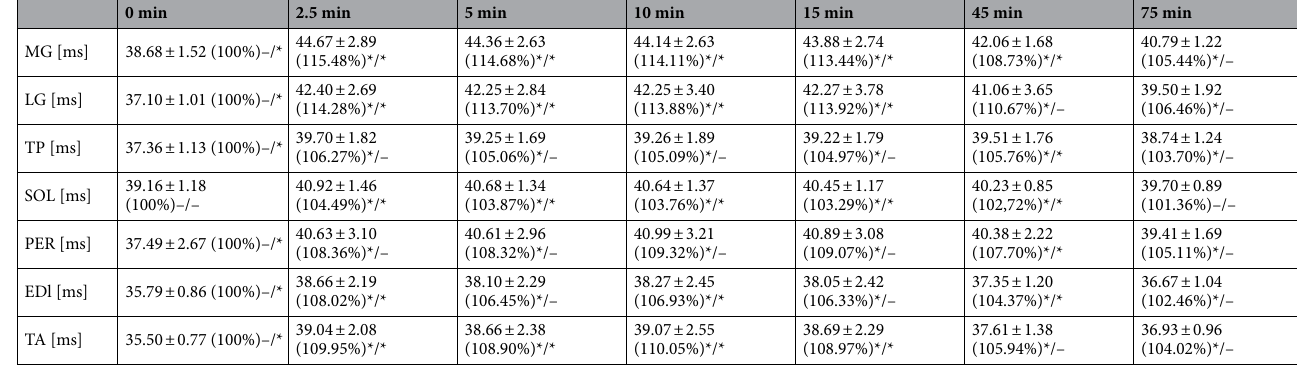
Table 2. Absolute and relative changes of the T2 relaxation times during prolonged running. */* marking significant difference ( p < 0.05) compared to baseline (0 min) (* before diagonal slash) or 75 min timepoint (* after diagonal